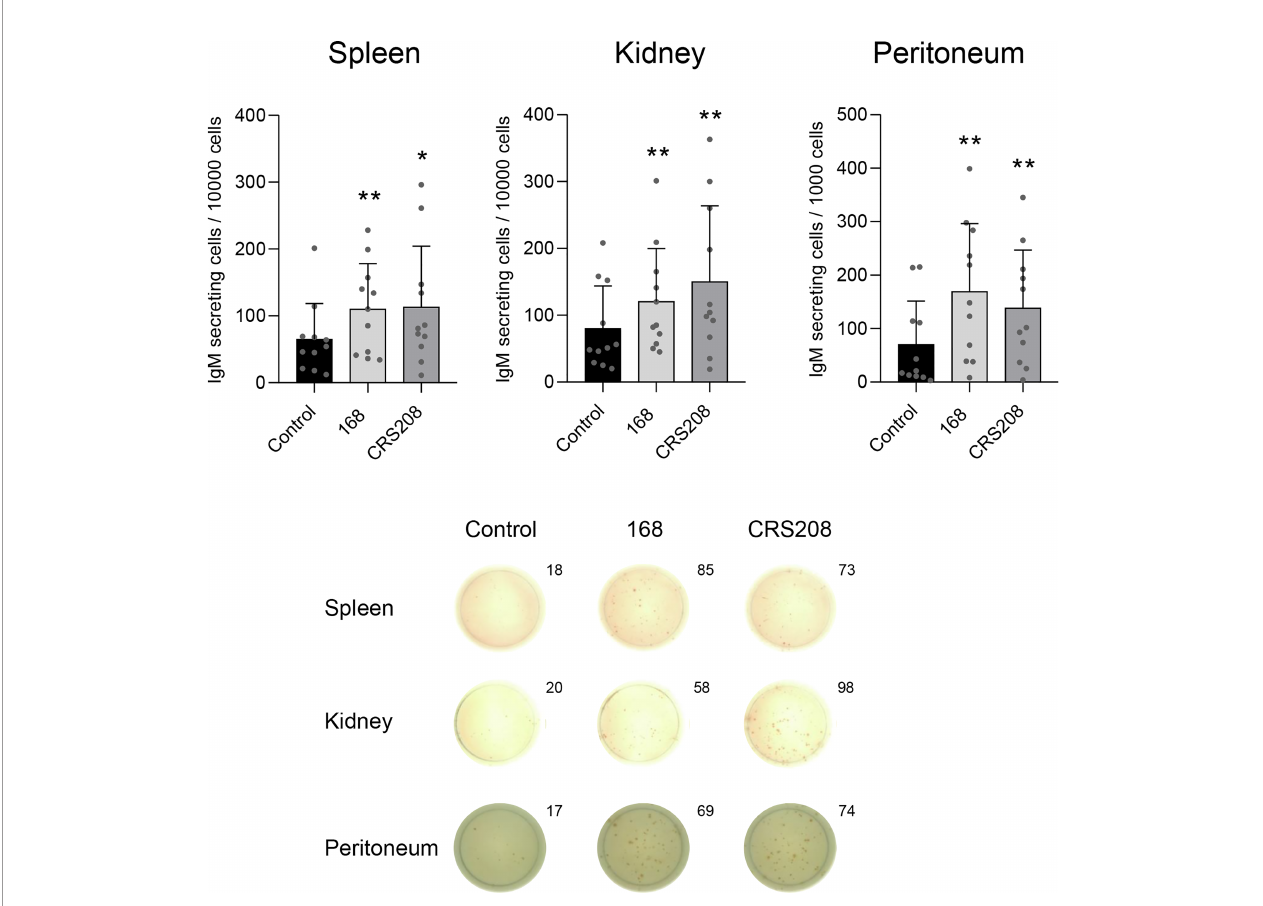
FIGURE 3 | Effect of B. subtilis 168 and CRS208 strains on the number of IgM-secreting cells. ELISpot analysis was used to estimate the number of IgM-secreting cells in spleen, kidney and peritoneal leukocytes incubated with 1x10 7 cfu/ml B. subtilis 168 or CRS208 strains. Controls not treated with bacteria were also included. Cells were cultured for 48 h and then plated in ELISpot plates, previously coated with anti-IgM for a further 24 h. Quanti fi cation of spot forming cells are shown (mean + SD; n=12) along with representative wells from one individual (below). Statistical analyses were performed using paired a two-tailed Student ’ s t -test of ln(Y) transformed data. The normal distribution was con fi rmed using the Shapiro-Wilk test. Asterisks indicate signi fi cant differences in stimulated cultures compared to control cultures, where * p ≤ 0.05 and ** p ≤